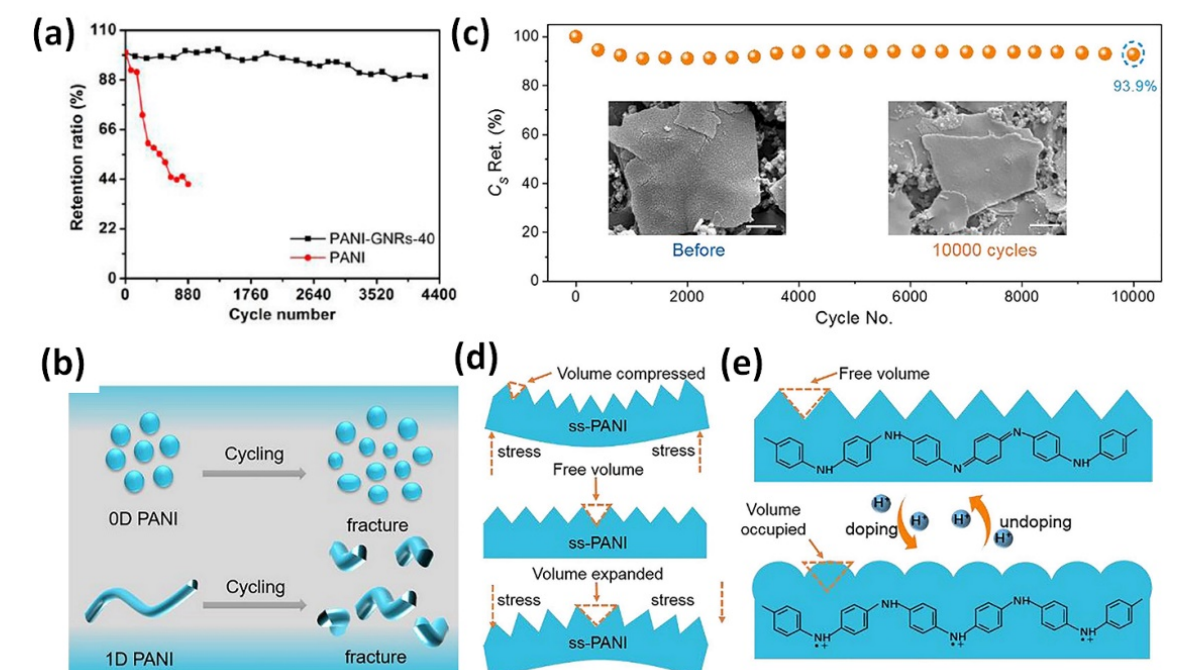
Figure 1. Cycling stability of pristine PANI and PANI with graphene nanorods (GNRs) (aniline to GNRs as 40:1) at a current density of 1 A/g measured in two-electrode cell ( a ) (Reprinted with permission from [30]. Copyright 2013 American Chemical Society). Illustration of structural disintegration of traditional conductive polymers that leads to poor cycling stability ( b ). Cycling stability of ss-PANI based flexible supercapacitor ( c ). The inset shows morphology unchanged before and after cycling. Illustrations of free volume between adjacent secondary mastoid structure can stabilized the ss-PANI through mitigating stress accumulation ( d ) and of doping/undoping processes within the structure that effectively mitigated the volume change ( e ). (Reprinted from [31], Copyright 2021, with permission from Elsevier).